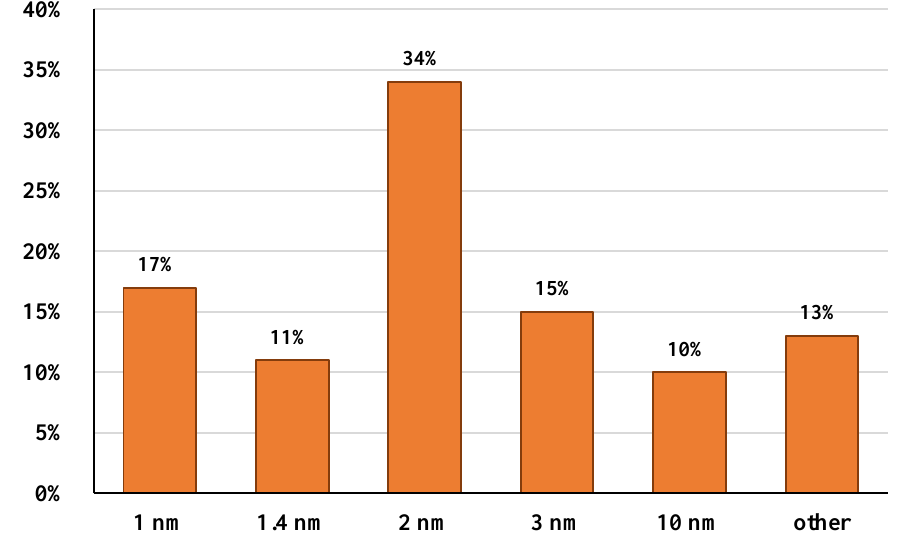
Figure 3. The portion of the reviewed papers using various spectra intervals.